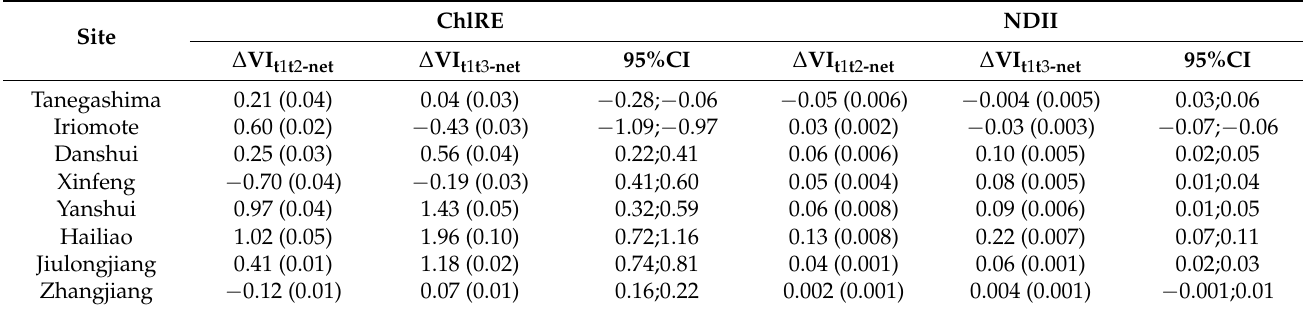
Table 4. Net change (standard error) of the chlorophyll red-edge index (ChlRE) and normalized difference infrared index (NDII) between t1 and t2 ( ∆ VI t1t2 = VI t1 − VI t2 ), and t1 and t3 ( ∆ VI t1t3 = VI t1 − VI t3 ) for the eight mangrove sites in the East Asia,